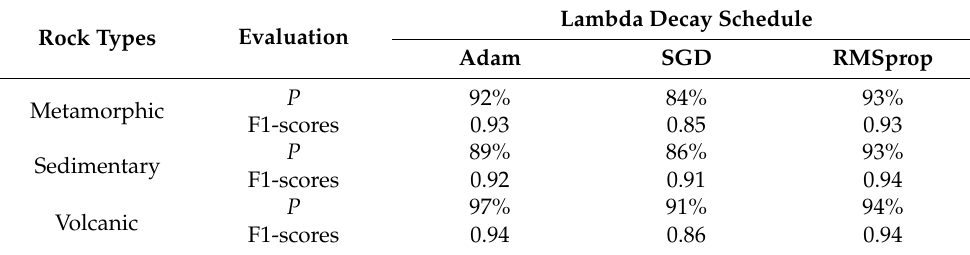
Figure 20. Confusion matrixes: ( a ) RMSprop optimizer; ( b ) SGD optimizer; ( c ) Adam optimizer. Table 7. Detailed classification results for all rock